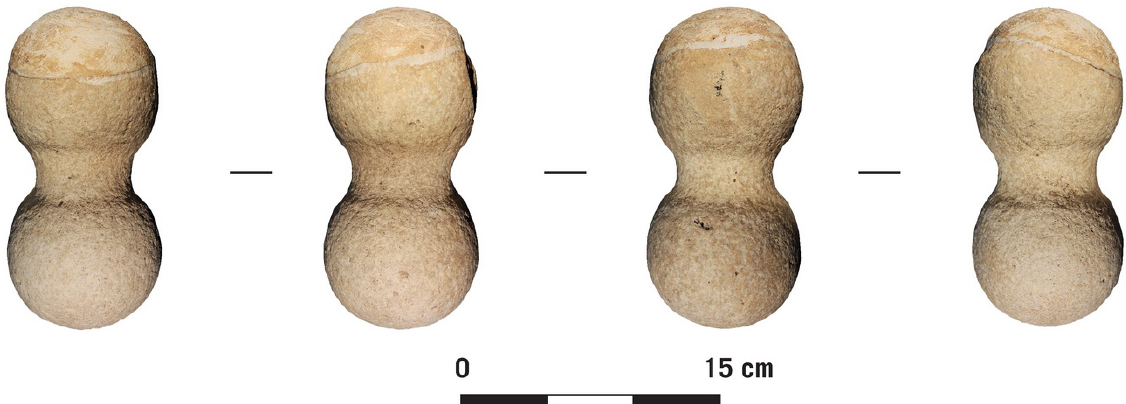
Figure 5. Lithic hammerstone ID 9115 observed in four different views. The tool has an uncommon morphology with globular ends and an extremely narrowed central